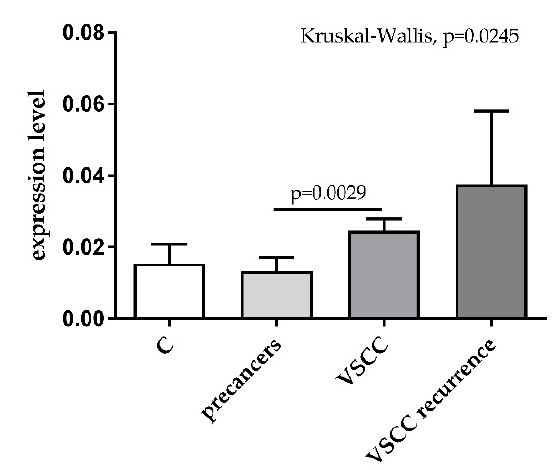
Figure 1. Expression levels of miR-431-5p in plasma samples of healthy blood donors (C, n = 15), patients with precancer lesions ( n = 29), and patients with primary (VSCC, n = 98) and recurrent (VSCC recurrence, n = 9) vulvar malignant tumors.